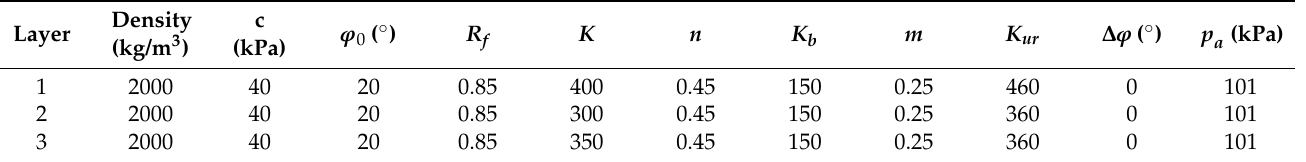
Figure 3. Outline and discrete grids of the benchmark model. Table 1. Material parameters.